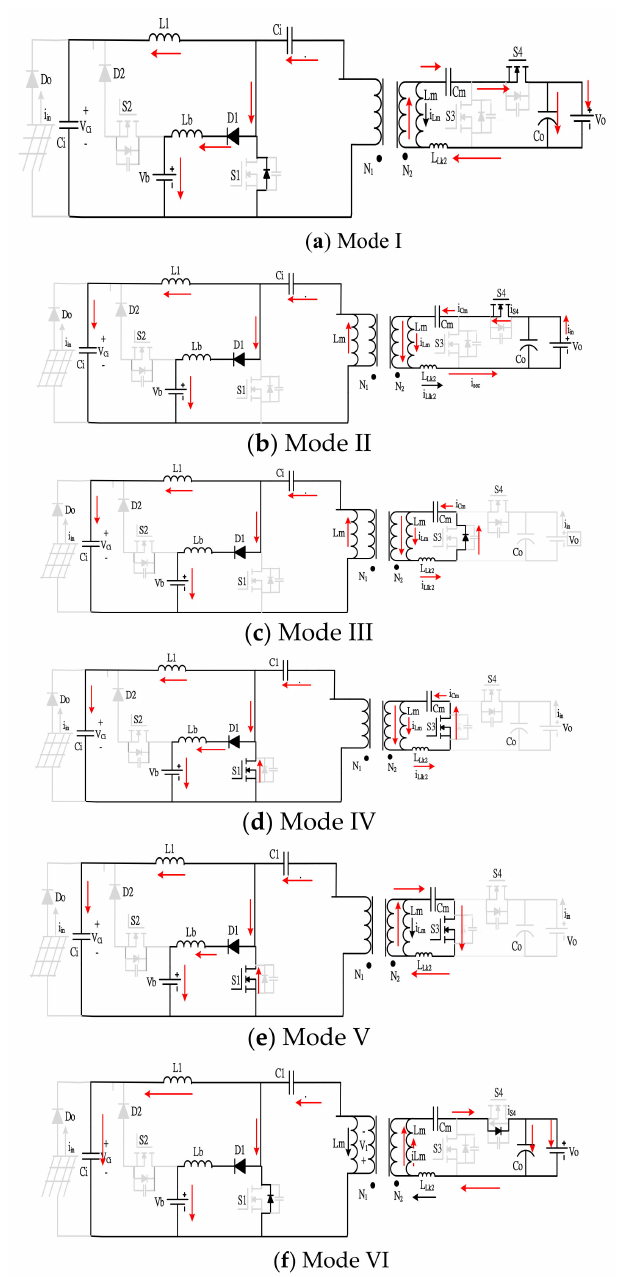
Figure 9. Operating diagram of each mode in Stage 3: ( a ) Mode I, ( b ) Mode II, ( c ) Mode III, ( d ) Mode IV, ( e ) Mode V, and ( f ) Mode